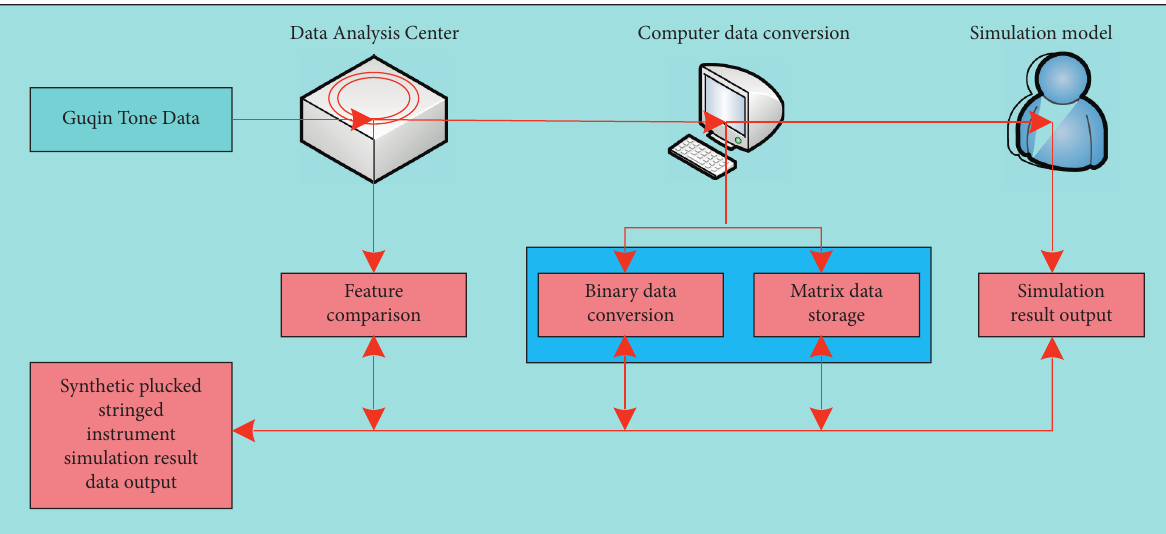
Figure 1: Data analysis process of piano sound simulation model based on computer composition technology.